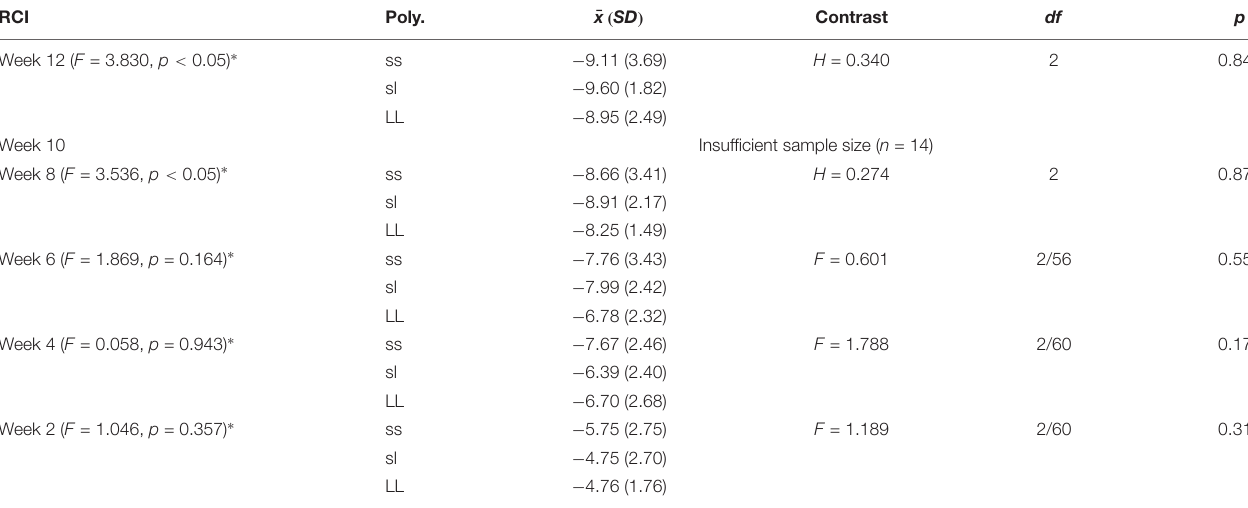
Week 2 ( F = 1.046, p = 0.357) ∗